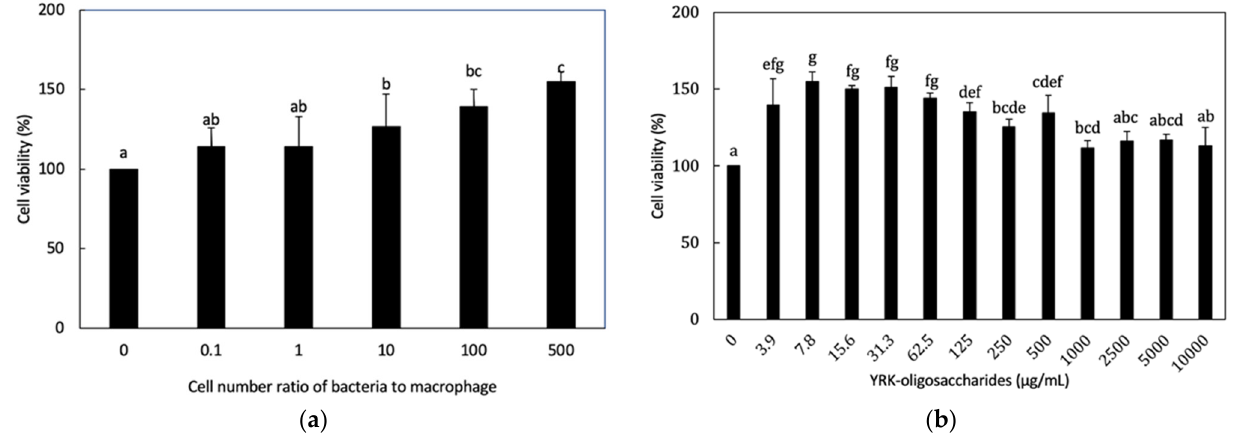
Figure 1. Effects of L. lactis SG-030 and oligosaccharides on the cell viability of RAW 264.7 cells. ( a ) Effect of L. lactis SG-030 on RAW 264.7 cell viability; ( b ) Effect of oligosaccharides on RAW 264.7 cell viability. Different letters show significant differences among groups at p < 0.05 (n ≥ 3). YRK-oligosaccharides: glucooligosaccharides from W. cibaria YRK005.